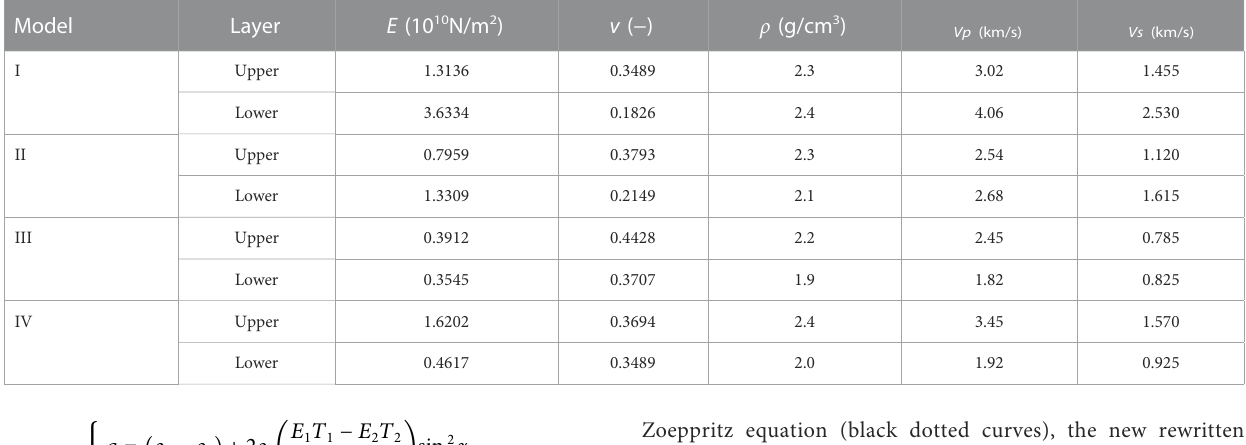
TABLE 1 Elastic parameters of four single-interface models with four AVO classes.